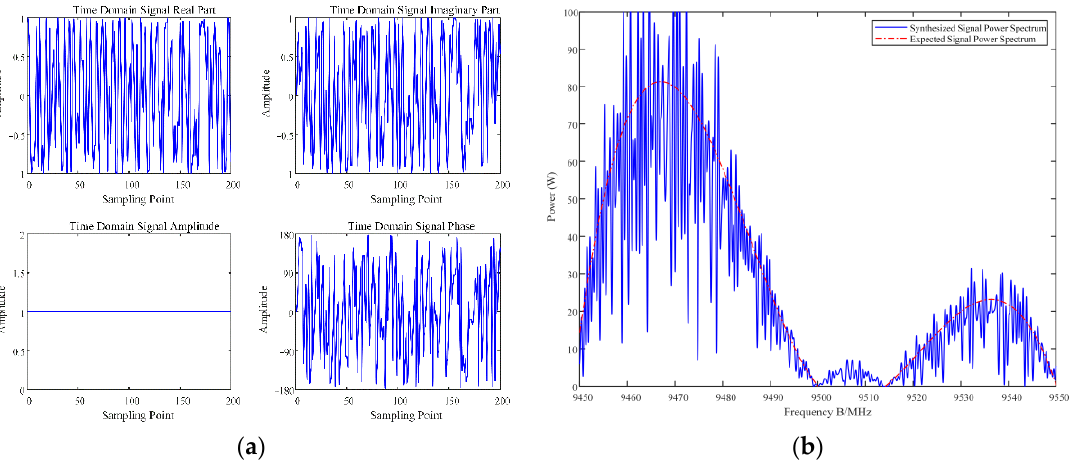
Figure 14. Time domain waveforms of the optimal radar anti-jamming strategy. ( a ) Magnitude and phase of the synthetic radar signal; ( b ) spectrum fitting results of the radar signal.